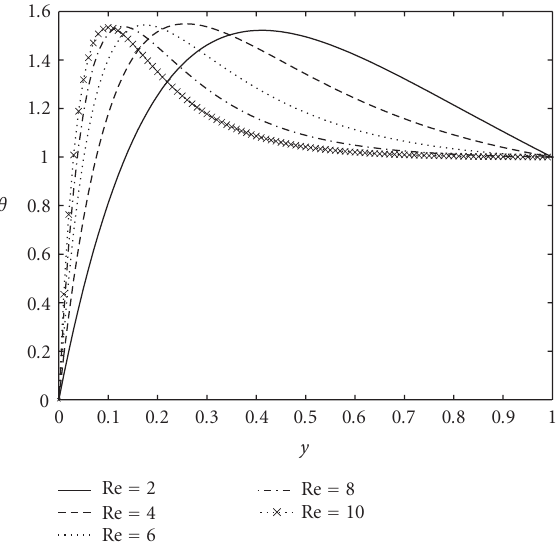
Figure 5.2. Temperature profile for Pr = 0 . 72, ω = 6 . 0, Ec = 10 . 0, z = 0 . 5, t = 0 . 2, (cid:3) = 0 . 2.